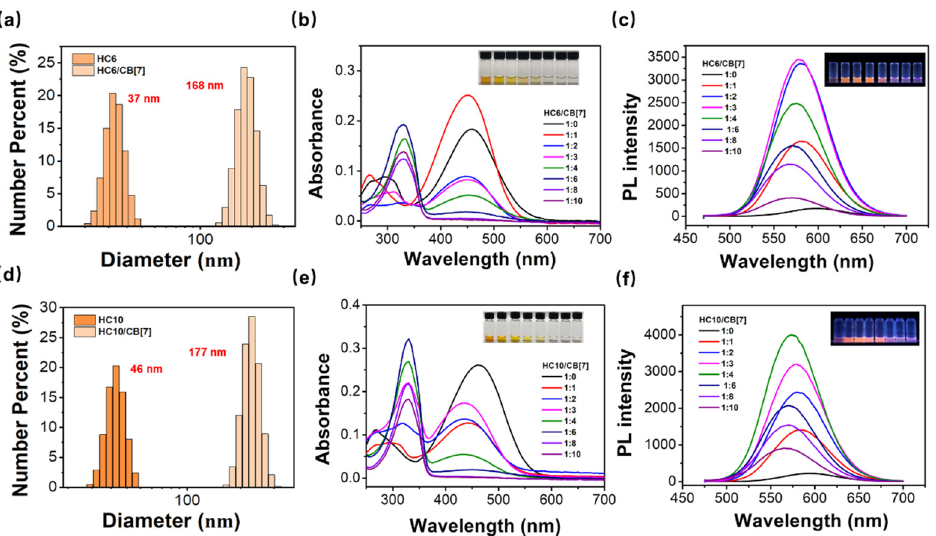
Figure 1. ( a ) The particle size distribution of HC6 and HC6/CB[7], HC6:CB[7] = 1:10. ( b , c ) UV-vis and fluorescence emission spectra of HC6 assembled with different proportions of CB[7] in aqueous solution. ( d ) The particle size distribution of HC10 and HC10/CB[7], HCs:CB[7] = 1:10. ( e , f ) UV-vis and fluorescence emission spectra of HC10 assembled with different proportions of CB[7] in aqueous solution. [HC6/HC10] = 25 μ M, [CB[7] = 0, 25, 50, 75, 100, 150, 200, 250 μ M, and the photos of HCs/CB[7] with different proportions of CB[7] under the white light or UV light (inset).